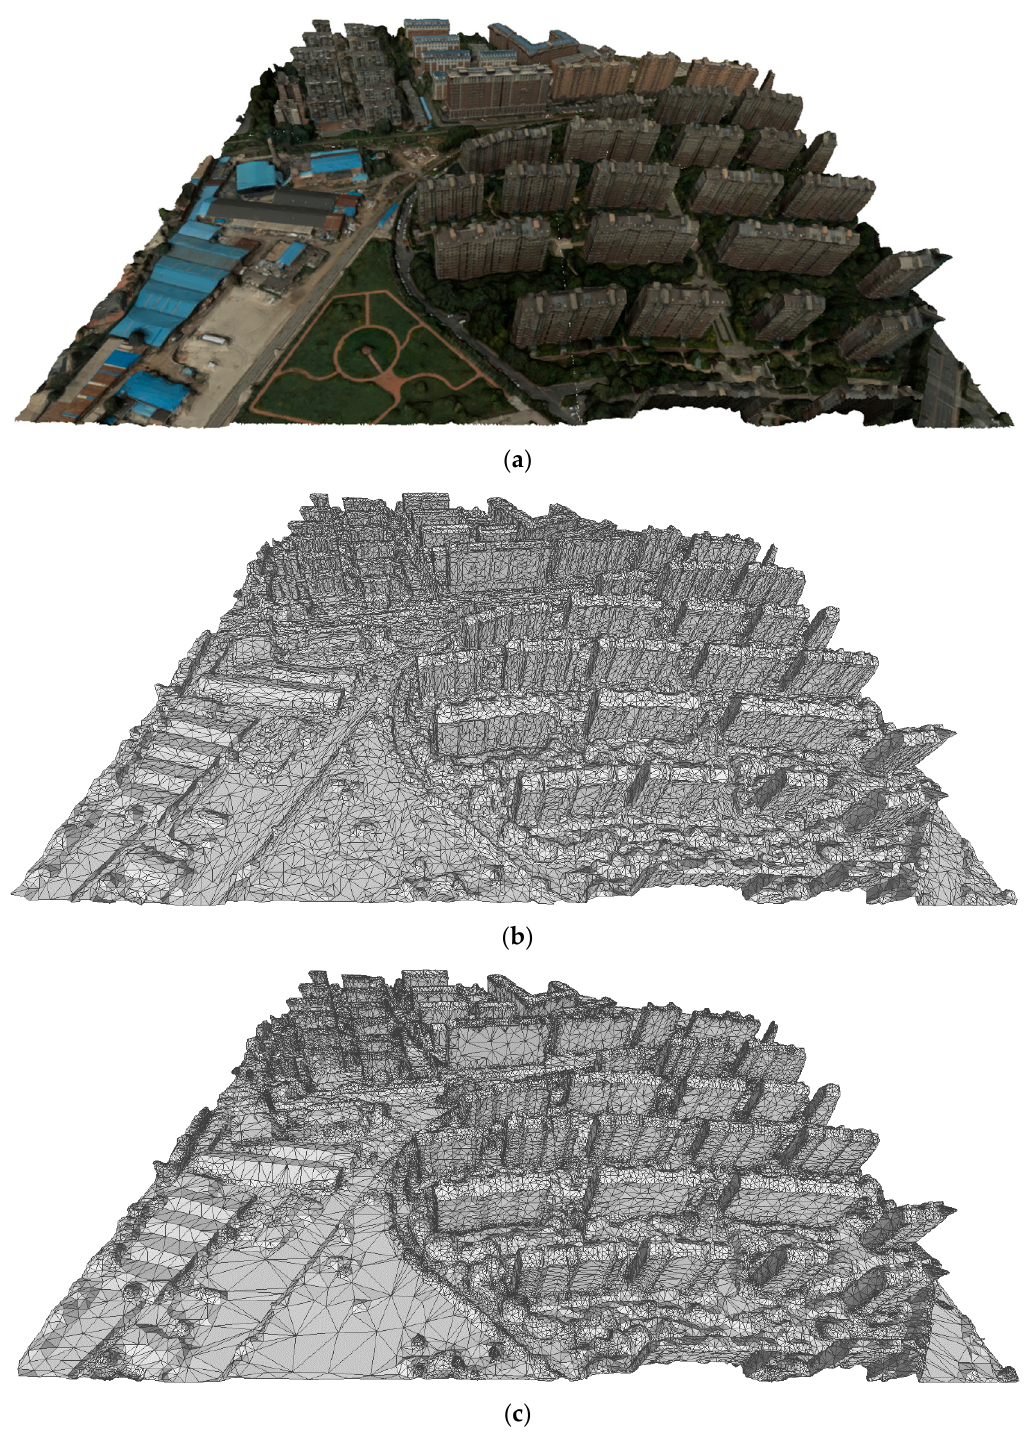
Figure A1. A tile extracted from scenery one. Simplified surfaces are both at level 7. DVDC ( λ = 2) seems better than aQSlim for its high simplification rate and greater planarity at planar surfaces and detailed surfaces with more geometric elements. Therefore, there is an urgent need to create numerical analyses for such observations, based on which we launched the research in this article. ( a ) Input surface with texture; ( b ) aQSlim; ( c ) DVDC ( λ = 2